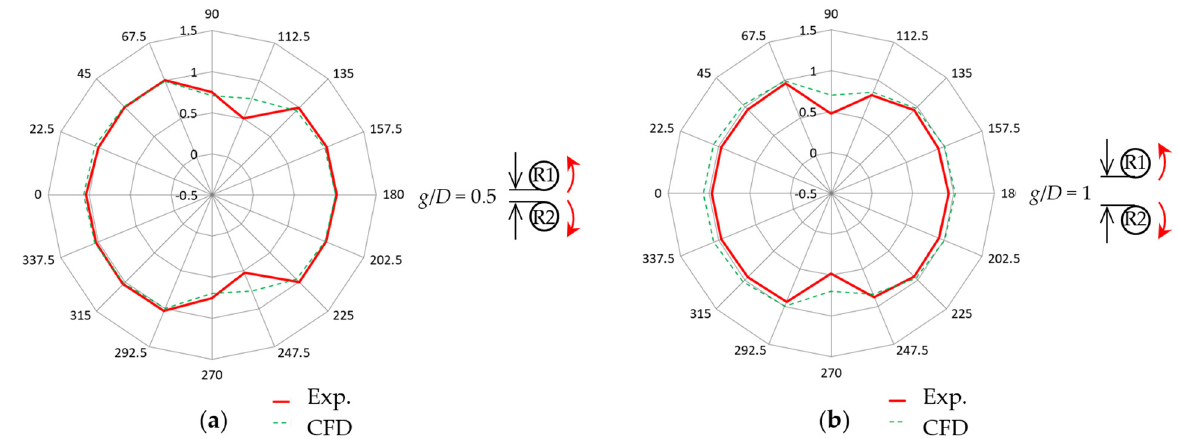
Figure 16. Comparison between the experimental and CFD results on 16-wind-direction dependence of average normalized rotational speed in a pair of VAWT models in IR configuration at V = 14 m/s: ( a ) g / D = 0.5; ( b ) g / D = 1.